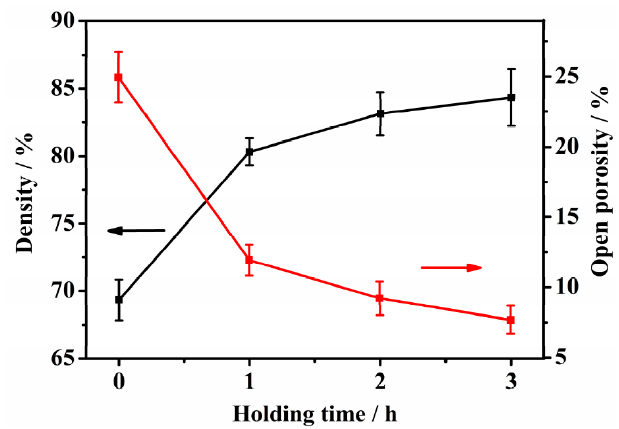
Figure 6. Relative densities and open porosities of the Fe-Mn-Si compacts sintered at 1200 °C as a function of the isothermal holding time.